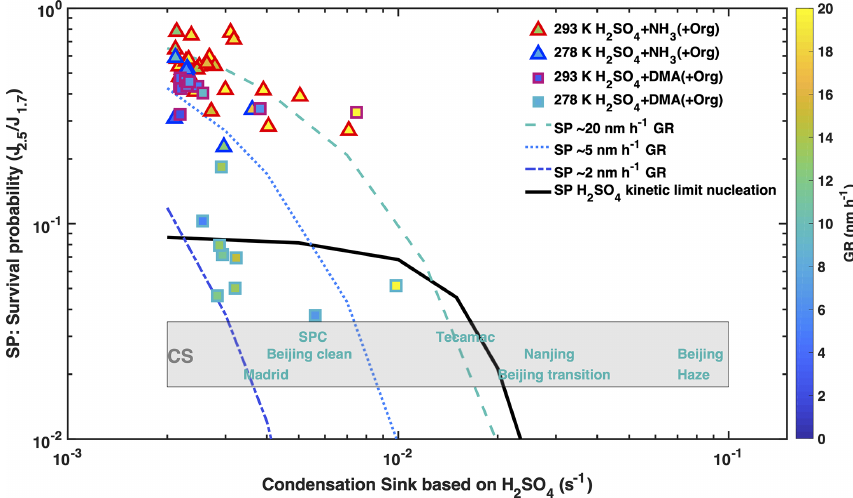
Figure 5. Influence of OxOrg and DMA on survival probability: survival probability (SP) vs. condensation sink (CS 6 ). The survival probabil- ity (SP) is calculated as the ratio between the formation rates at 2.5 and 1.7nm. CLOUD data were recorded at 60% RH and 278K (blue and cyan contoured) or 293K (red and magenta contoured) with 1 to 2ppbv NH 3 . Experiments without DMA injection are shown by triangles, and experiments with 4pptv DMA by squares. The sub-3nm growth rate is given by the colour of the symbols. The loss rates of newly formed particles are approximated by the condensation sink of sulfuric acid to particles larger than 6nm ( x axis). Also shown are typical CS from observations in the polluted boundary layer at the following locations: Po Valley regional (San Pietro Capofiume, SPC) (Kontkanen et al., 2017), Madrid (Carnerero et al., 2018), Tecamac (Kuang et al., 2010), Nanjing (Yu et al., 2016) and Beijing (clean, transition and haze) (Cai et al., 2017). Dashed lines are calculated survival probabilities of 2.5nm particles with growth rates of 2, 5 and 10nmh − 1 . The solid line is the survival probability of 2.5nm particles if 8 × 10 6 cm − 3 sulfuric acid nucleates at the kinetic limit, which would for example at CS 6 = 0.002s − 1 (representing wall loss) correspond to a nucleation rate J 1 . 7 of 4000cm − 3 s − 1 (Fig. 1) and a growth rate of 11nmh − 1 (Fig. 4a). The high production rate of nucleating clusters significantly reduces the survival probability, due to cluster–cluster collisions. How- ever, at the same time, this increases the growth rate such that the survival probability is unaffected by the CS until it becomes comparable to the loss rate from cluster–cluster collisions.